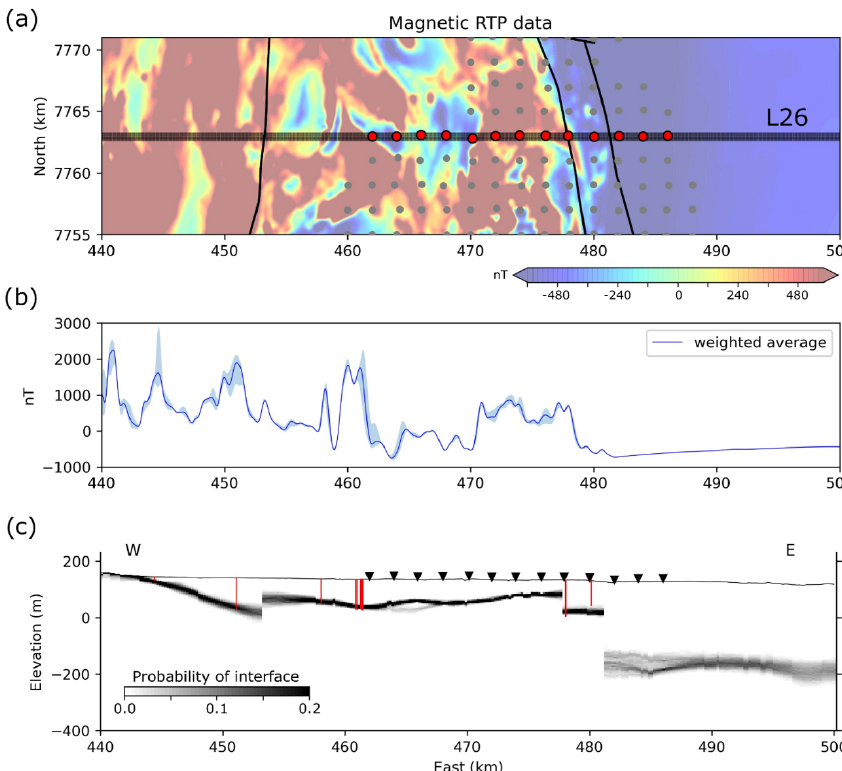
Figure 9. Data preparation. (a) Map view of the data in the region of interest. The greyed-out area corresponds to the zone considered for the averaging of the magnetic data. Red points are MT soundings considered in this study. Grey circles are other MT soundings not used in this study. Panel (b) shows data for magnetic inversion (solid line) and the envelope of the data from the 800m band around L26 (light blue shading). The shades of blue represent the weight assigned to the data points in the calculation of the average: the lighter the shade, the lower the weight. (c) Cover–basement interface probability p int (Seillé et al., 2021). Red lines are the drill holes, and their bottoms represent the intersection with the basement. The drill holes plotted are projected at a distance up to 800m away from the profile.